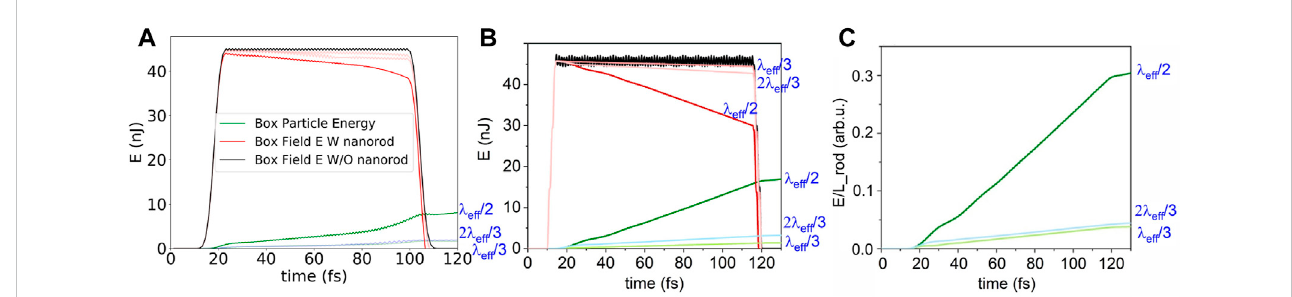
FIGURE 3 (color online) Optical response of the gold nanorod with different numerical methods and lengths, L = λ eff /2, λ eff /3 and 2 λ eff /3, (A) PIC, (B) FEM and (C) FEMwith normalized values to unit antenna length. The tendencies ofthetime-evolution of thenanorod energy determined by PIC and FEM are invery good agreement. The energy in the calculation box increases rapidly till about 20 fs, then it becomes constant (without nanoantenna) until the laser pulse lasts, at this moment the energy in thebox drops to zero. With thenanoantenna inthe box, theresonant antennaabsorbs agood part of thelaser energy, (green line), while much less with the non-resonant length antennas. There is a quantitative difference between the rates of energy increase, namely the slope is signi fi cantlysmallerforPICcomputations,accordinglythevalueachievedat106 fsisalsosmaller.Thesmallerslopeiscausedbythetunnelingoftheelectrons